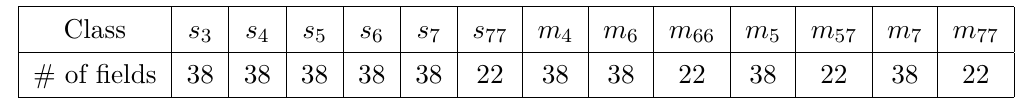
Table 2 . The number of scalar fields for each of the remaining 13 solution classes of [15], given for